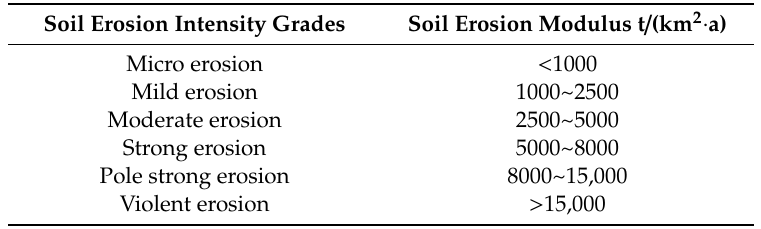
Table 2. Classification standard of soil erosion intensity grades [32].